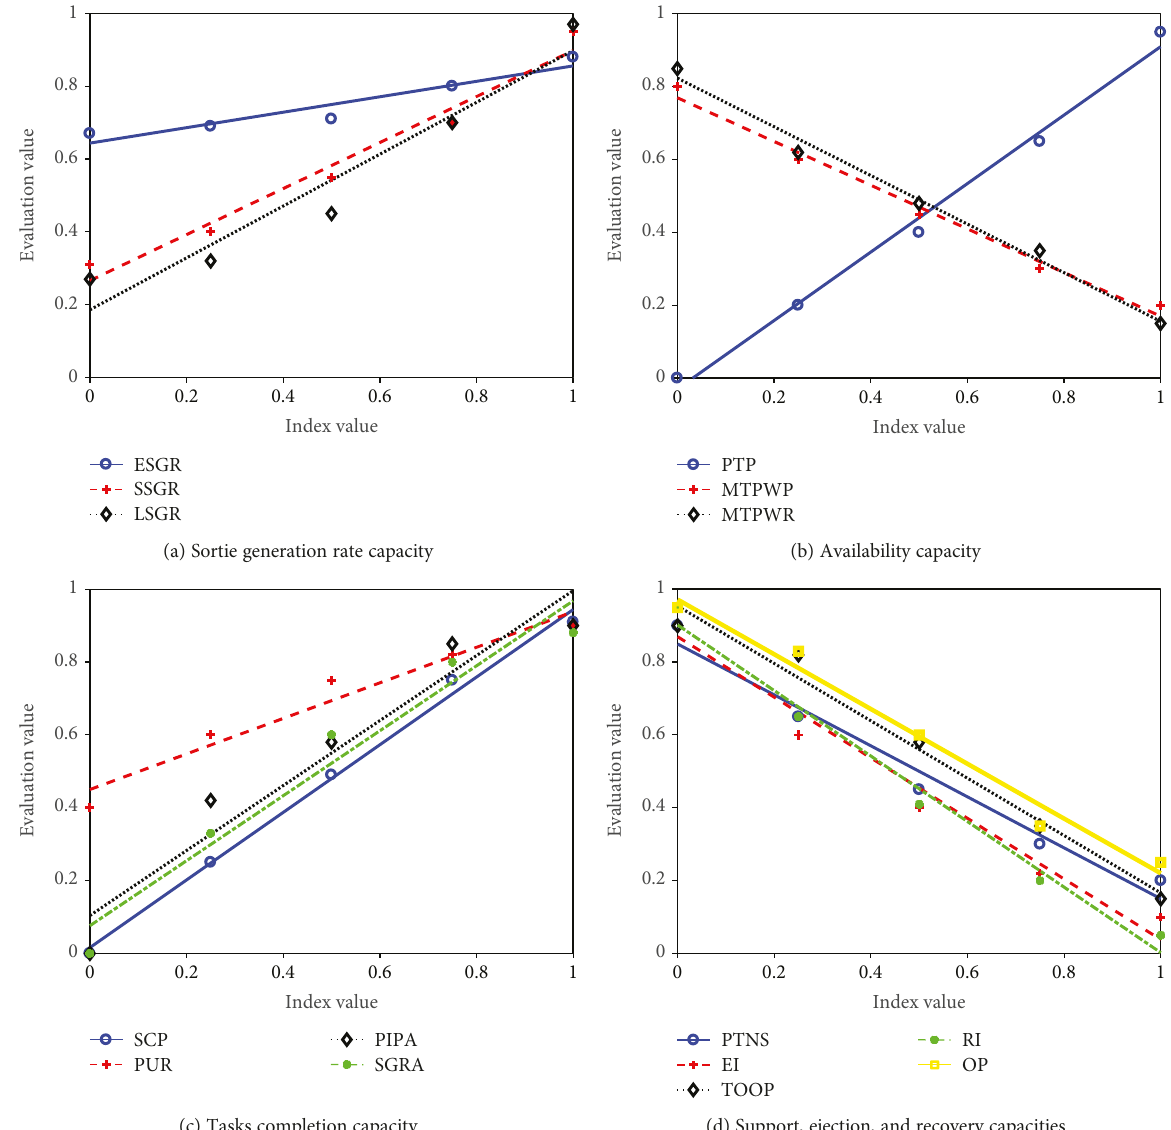
Figure 15: The in fl uence curves of 15 indexes on the sortie generation